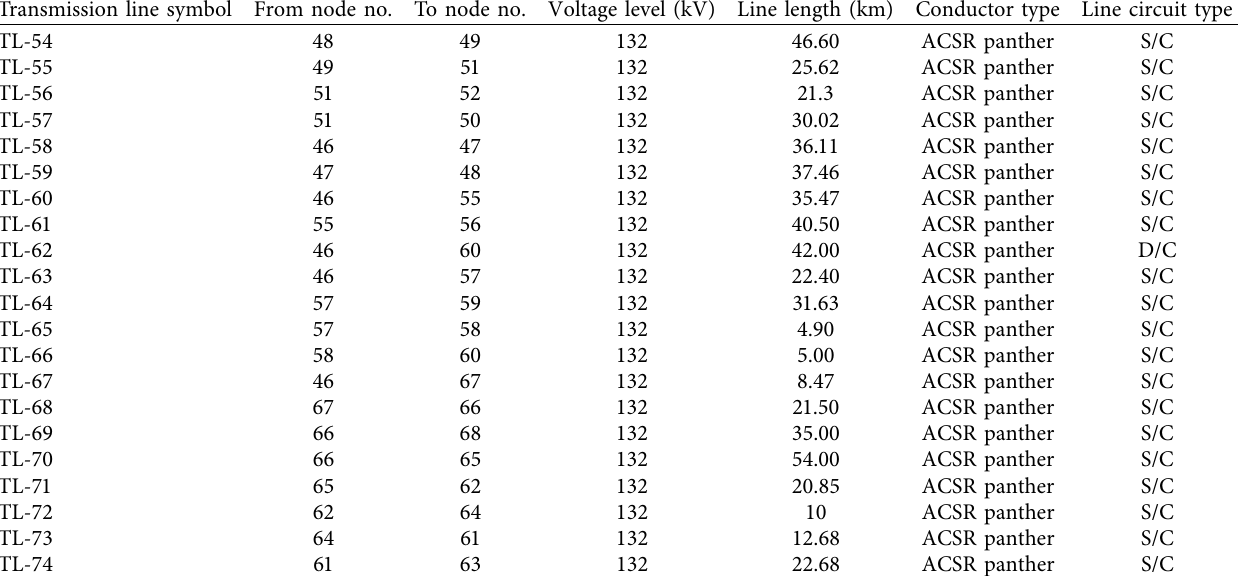
Table 5: Description of transmission lines (part-B).